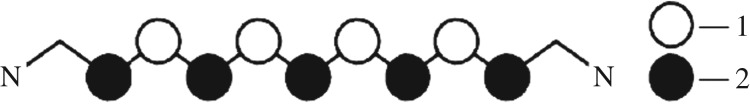
Ideal polymethine state [37,38]. Charges reside on carbon atoms of the polymethine chain in the ground state; charges: 1, positive; 2, negative [6]. (Original citation)—Reproduced by permission of The Royal Society of Chemistry.